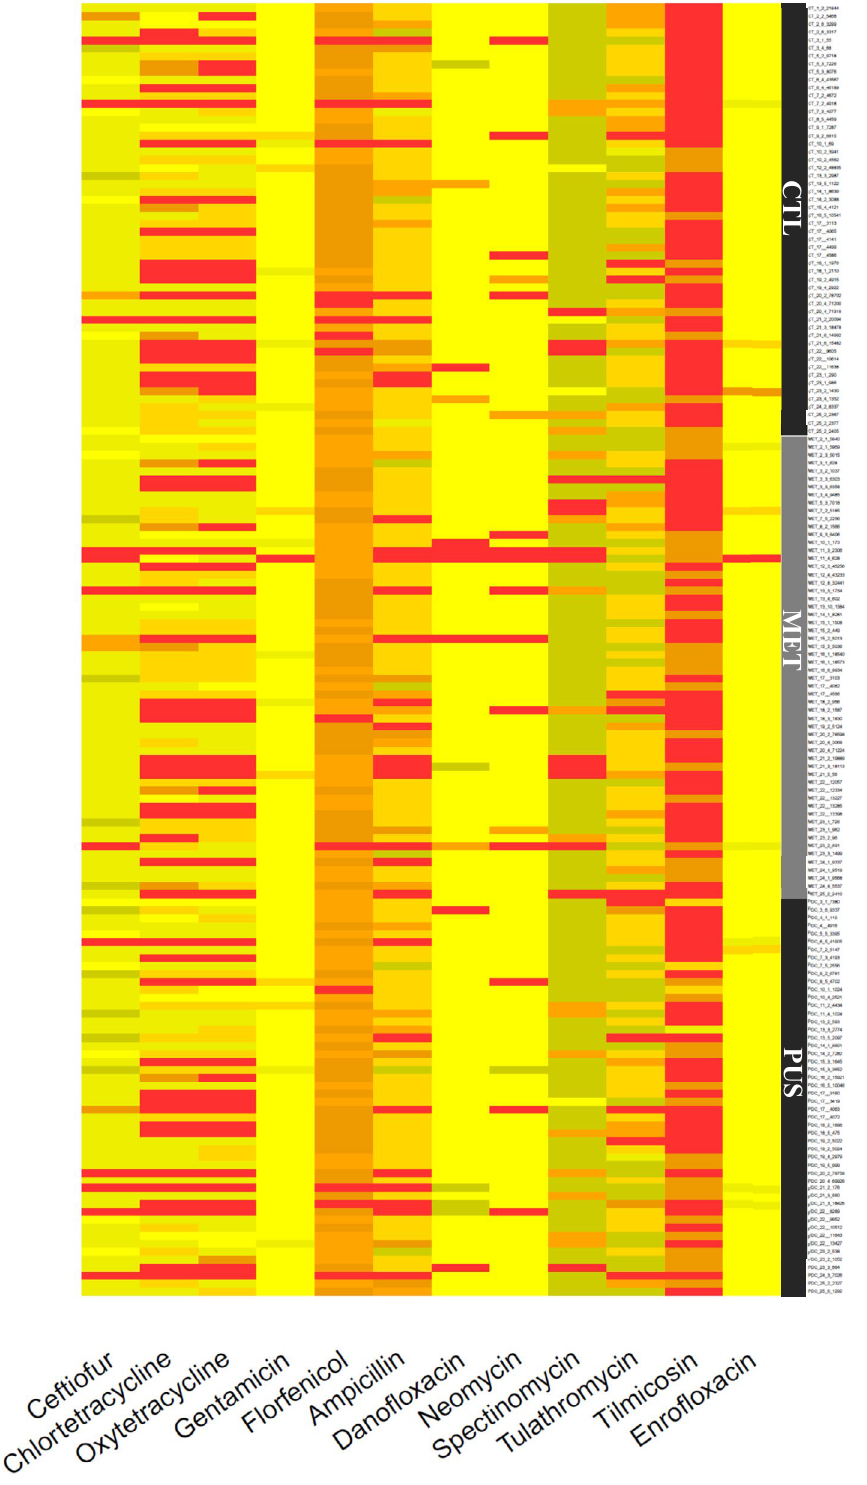
Figure 1. Heat map of MICs for 12 antimicrobials compared against 162 E. coli isolates grouped by clinical presentation group (CTL, MET, PUS). Each row represents an isolate that was categorized by percent decrease in the susceptibility